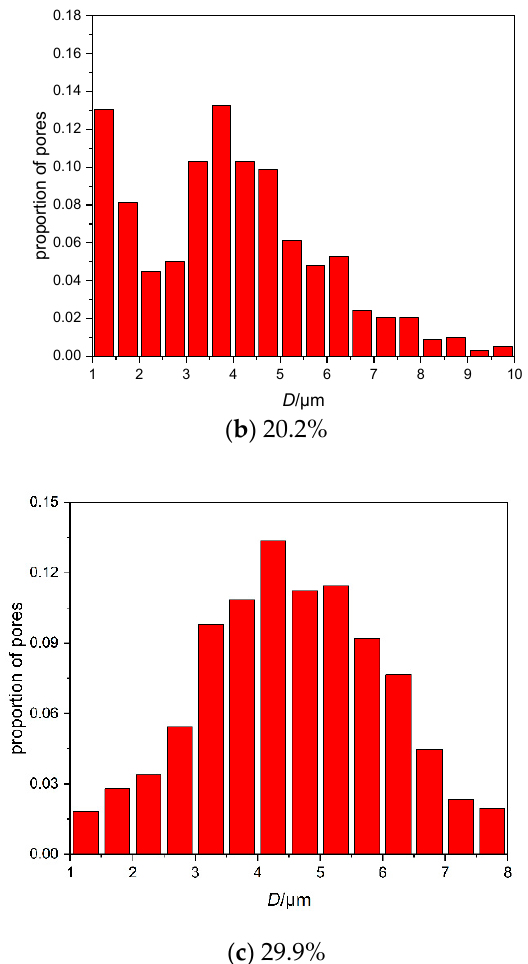
Figure 9. Pore size distribution of AP particles with different mass losses.